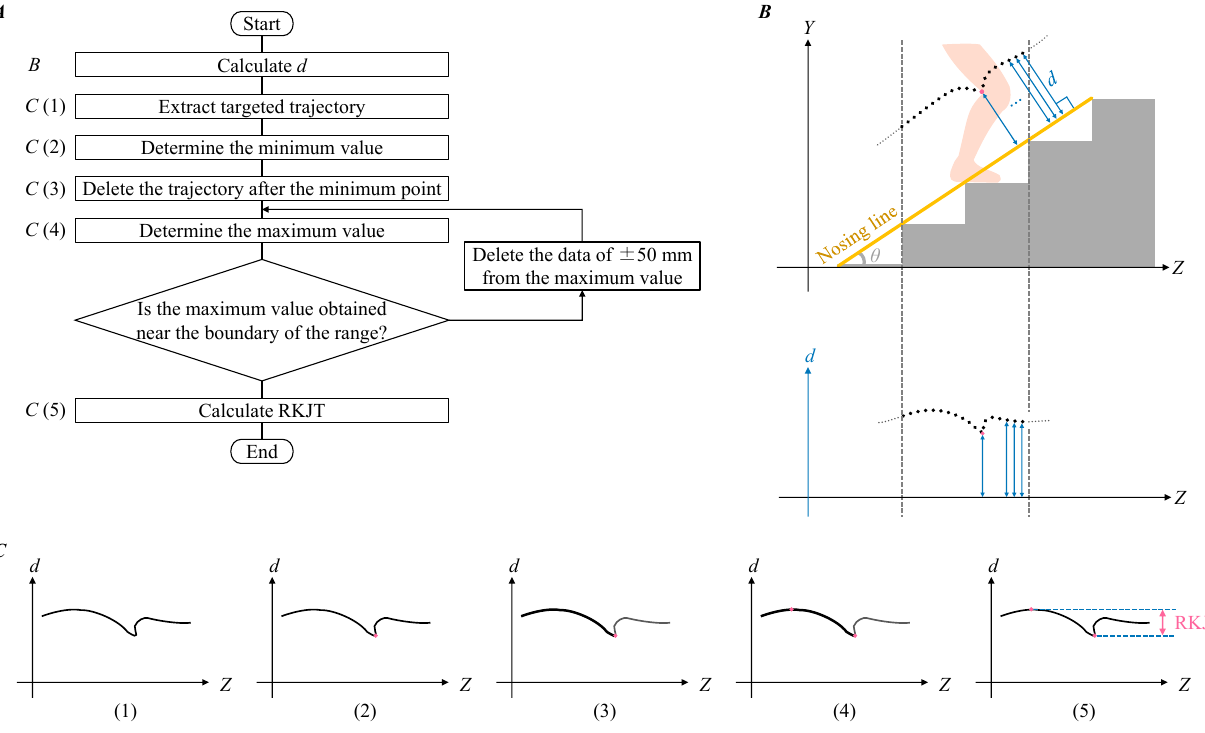
Figure 3. Definition and calculation procedure of range of knee joint trajectory (RKJT). ( A ) The flow of the procedure. ( B ) The distance ( d ) was calculated from the nosing line of the staircase to the knee joint trajectory. The black dotted line represents the knee joint trajectory. The nosing line of the staircase connects the stair nosing of all steps shown by the yellow line. The stair angle ( θ ) is the angle formed by the nosing line of the staircase and the horizontal lines ( Z ). ( C ) The description of the procedure is as follows: (1) The value d was calculated and extracted in the analytical range; (2) The minimum value was determined (pink dots); (3) The knee joint trajectory before the minimum value was extracted (bold black lines); (4) The maximum value was determined (pink dots); and (5) RKJT was calculated. When the maximum value was obtained near the boundary of the analysis range, the data of ± 50 mm was deleted from the maximum value, and phase (4) was